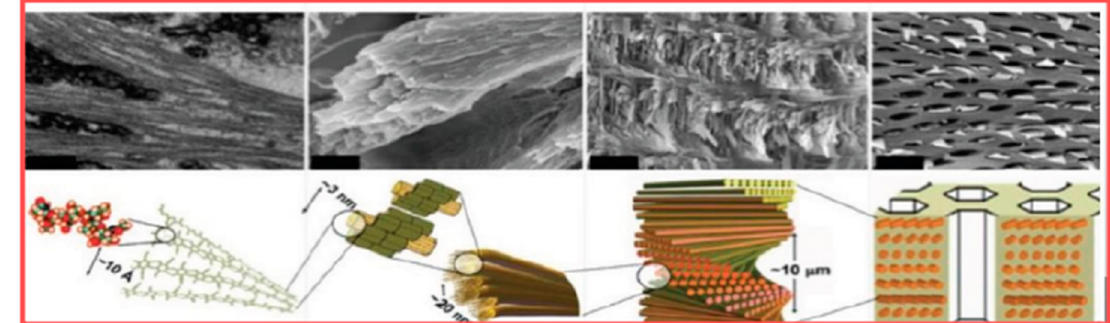
Figure 3. Chitin polymer organization (courtesy of Svetoslan et al. [46].